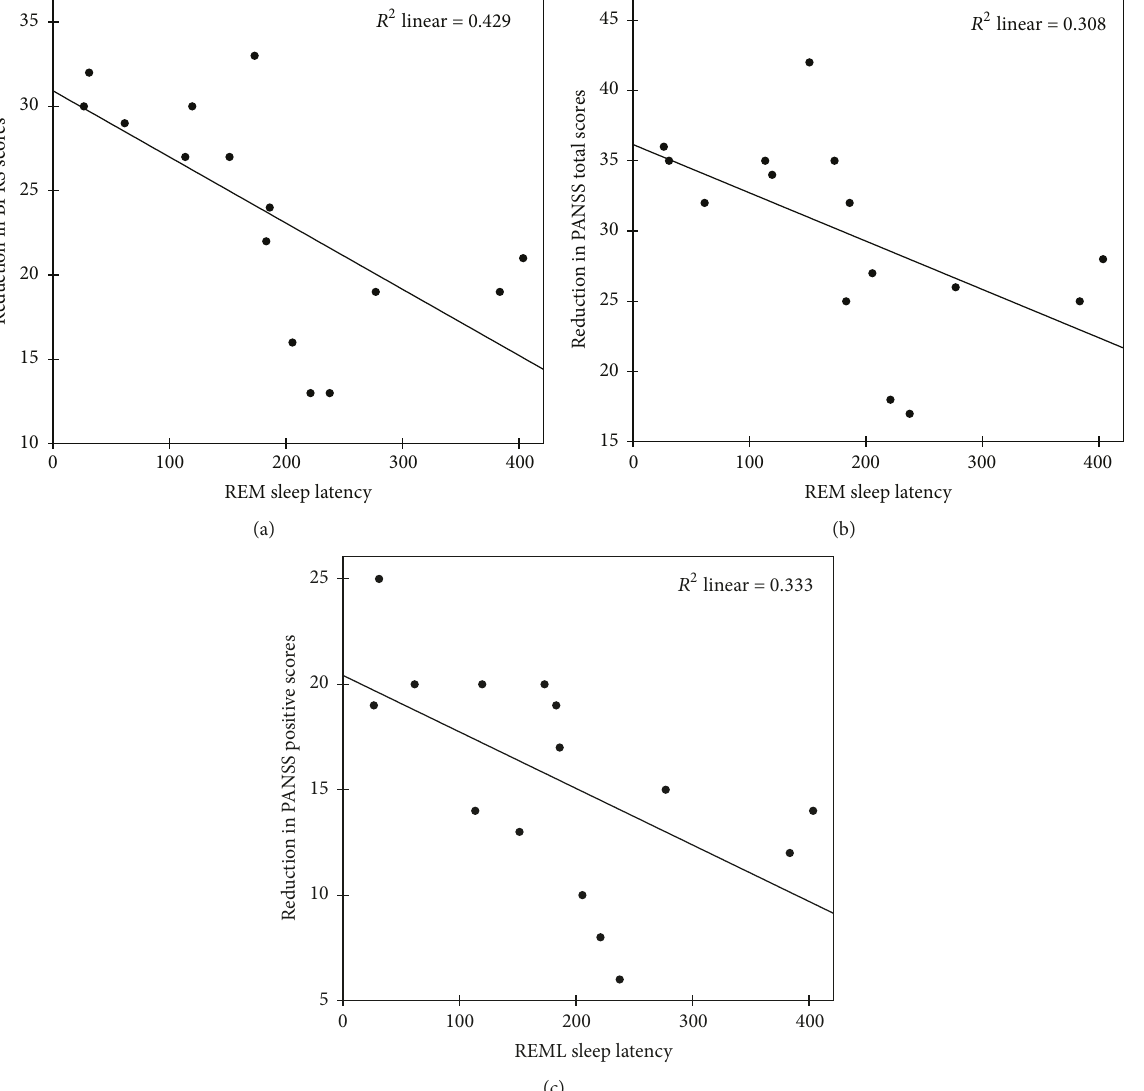
Figure 1: Scatter plot showing significant negative correlations between REM latency at baseline and reduction in BPRS total scores (a), reduction in PANSS total scores (b), and reduction in PANSS positive scores